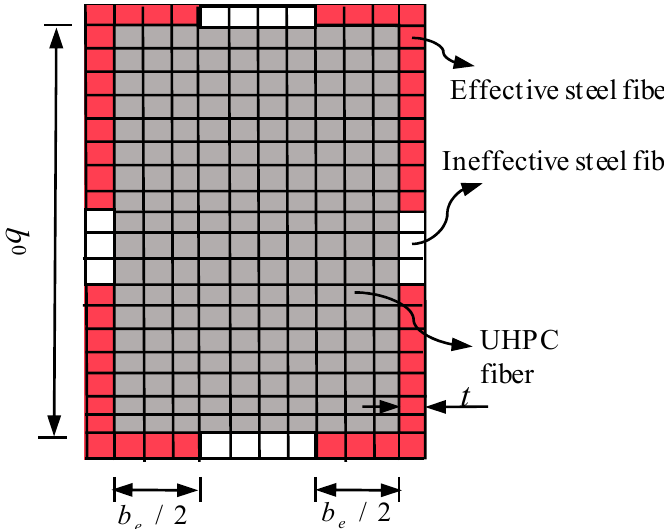
Figure 5. The e ff ective distribution width of the steel tube. Figure 5. The effective distribution width of the steel